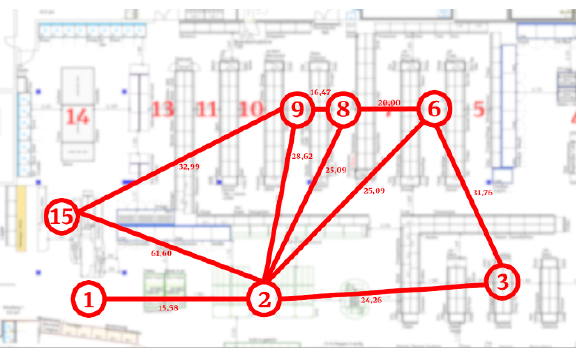
Figure 2. Partial representation of the oriented cost graph for order 8. Table 3. Simulation of travel times for 10 BOPS orders when the TSP optimization is implemented.